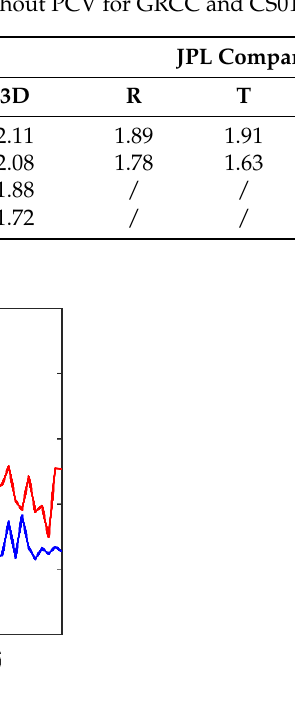
Figure 12. The difference in clock offset between solutions with and without PCV corrections.